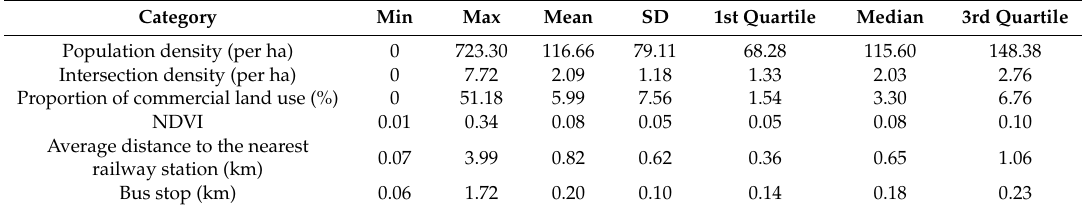
Table 2. Descriptive statistics of built environment (BE) variables of 758